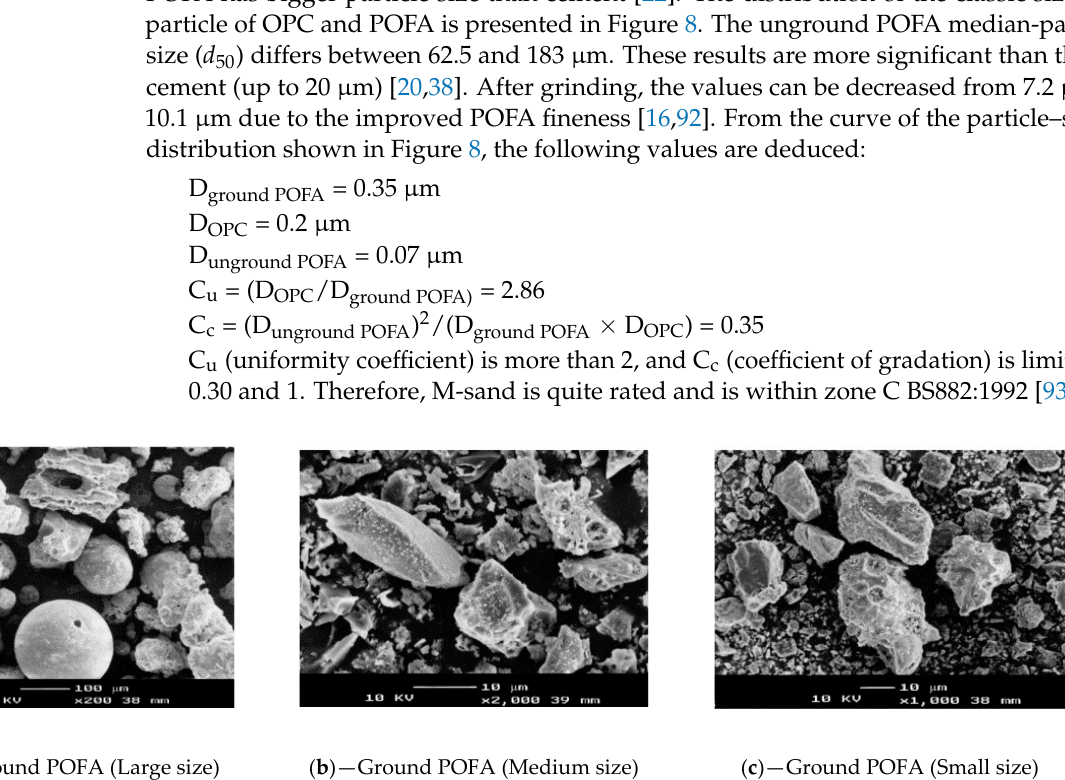
Figure 8. Particle size distributions of OPC and POFA [23,94]. Reprinted with permission from Elsevier [23,94]. 5.4. Fineness POFA fineness is found to develop the concrete strength attributable to its density, and homogeneity [22,32,47,49,60,62,63,75,81]. Reportedly, the concrete comprising 10% and 20% treated POFA increased the concrete strength. These results probably because of the contribution of POFA that behaves as a micro-filler used to seal the voids among the particles, leading to an increase in the concrete microstructure [11,29,74]. Based on previ- ous investigations, unground-POFA is finer than OPC and extra-fine than ground-POFA [11]. Thus, ground POFA is utilized to improve the degree of fineness and enhance the mixture’s reactivity and therefore increase concrete properties. The shape of a particle of POFA could be decreased by crushing in ball-mills and ground in a LAAM using a mild steel bar of 800 mm length and 12 mm diameter [12,19,20,32,65]. POFA is found to be less permeable with small particles after grinding [95]. In practice, the fineness of POFA is commonly measured regarding the weight of the rate passing via or being reserved in a sieve with a 45-µm opening. POFA has a larger specific surface area compared to OPC. The study reported that the rate mass of ground POFA and unground POFA that retained on sieve No. 325 is limited to 1.0–3.0% and 41.2–94.4%, respectively. Ranganath et al. [96] deliberated the effect of ash fineness on concrete strength development; coarse-particles’ utilization decreased the concrete strength. In general, POFA exhibits the utmost strength because of its high-fineness. Swamy [97] verified the effectiveness of finer 10 µm POFA in